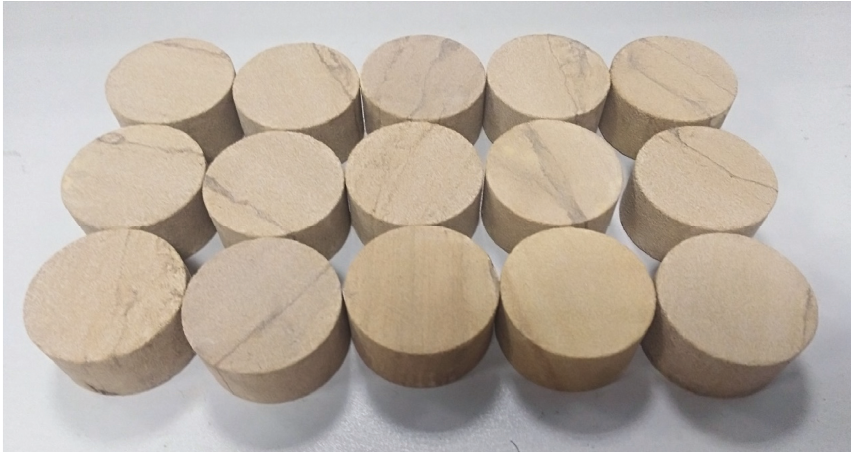
Figure 1: Yellow sandstone samples.